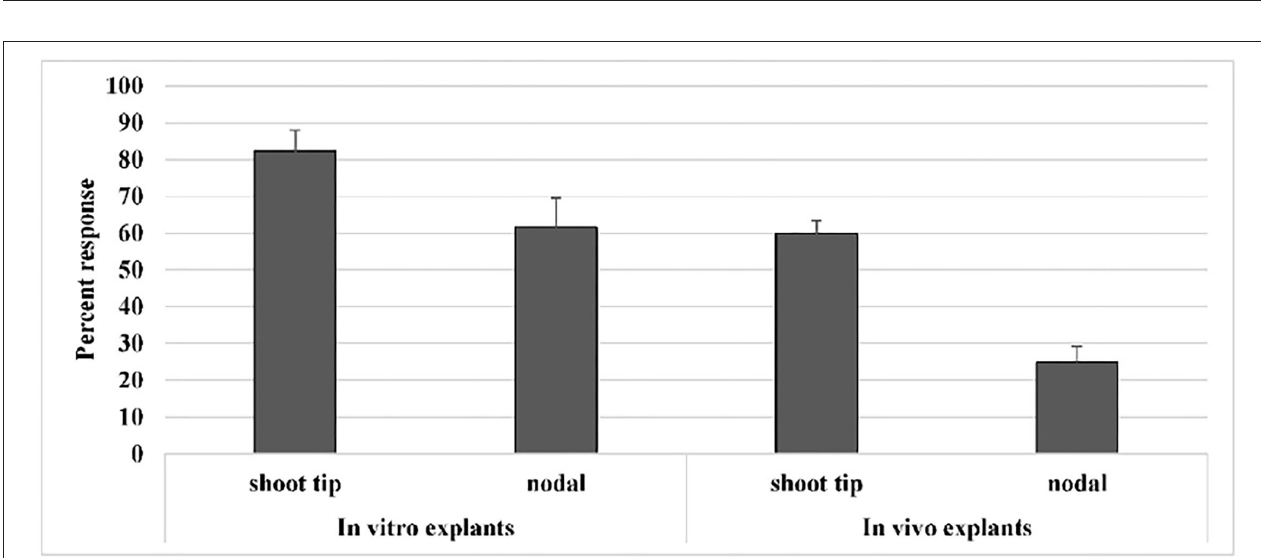
FIGURE 2 | Effect of type and source of explant on in vitro culture establishment of varieties of mung bean.